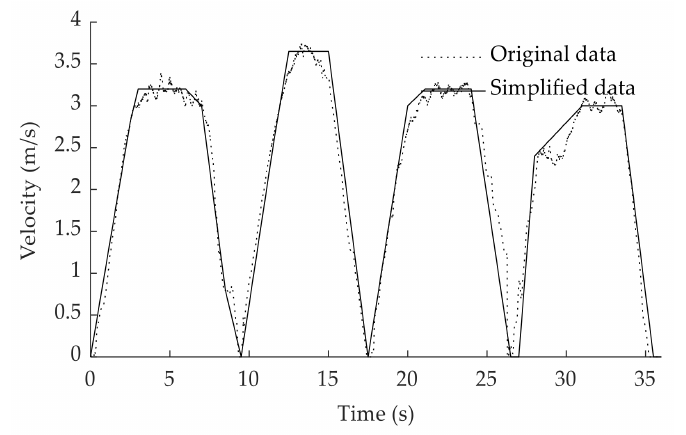
Figure 6. Velocity